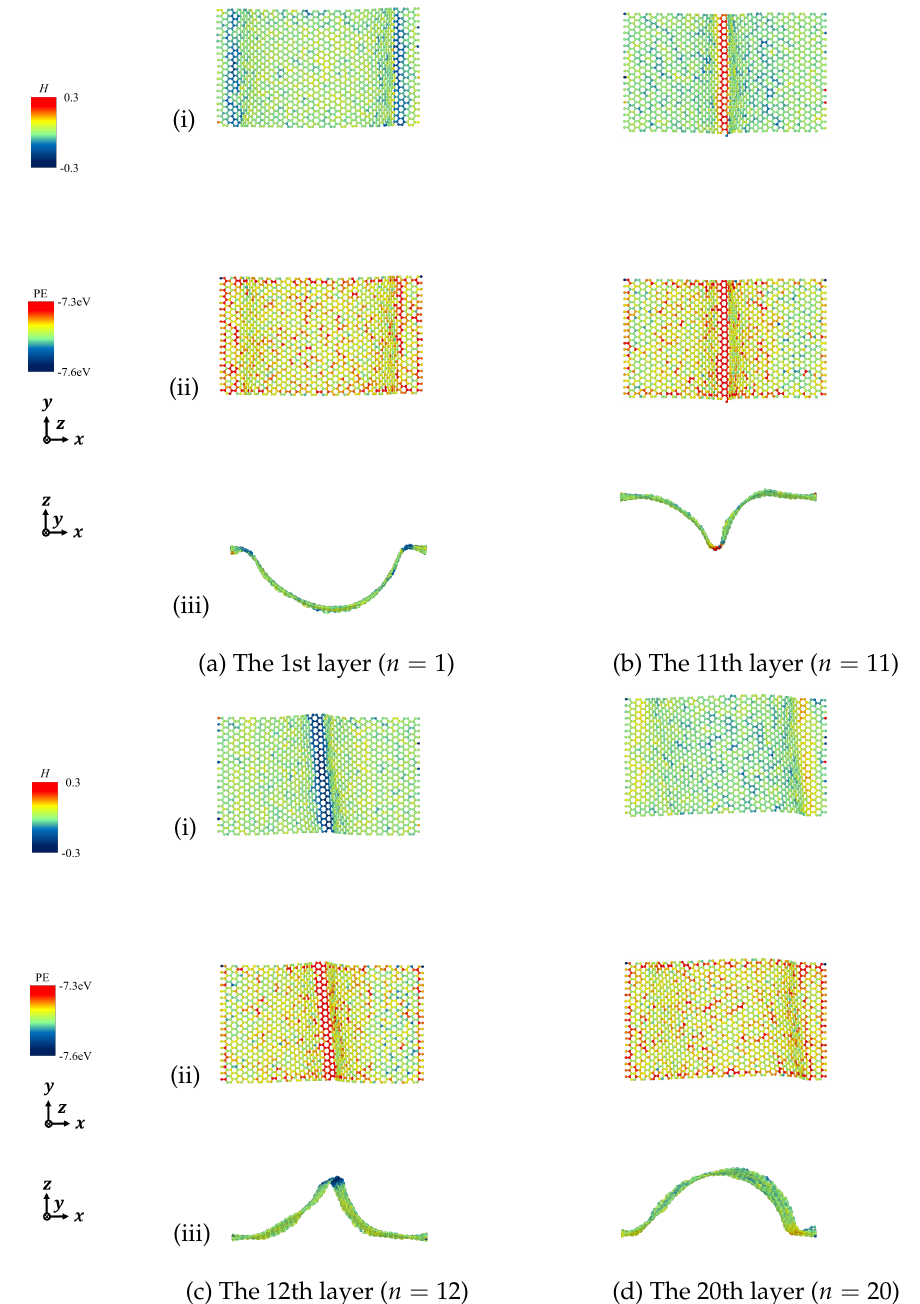
Figure 12. Mean curvature and site potential energy of curved surface of armchair graphite under compression ε = 0.20. (i) Site mean curvature, (ii) Site potential energy, and (iii) Mean curvature with deformation.